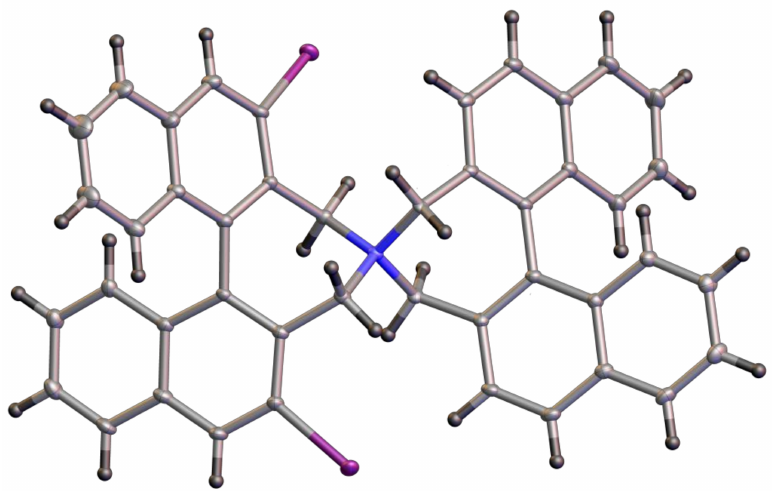
Figure 5. X-ray structure of 16 (counterion and solvent molecules